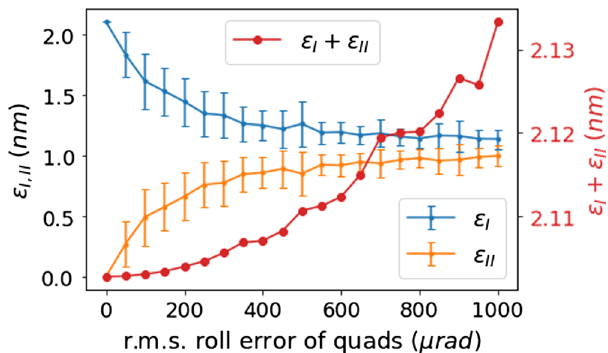
FIG. 7. On-resonance scheme: correlation between the beam eigenemittances with r.m.s. quadrupole roll errors when the ideal machine ’ s tune is on a difference resonance. Each error bar is the standard deviation for 50 random